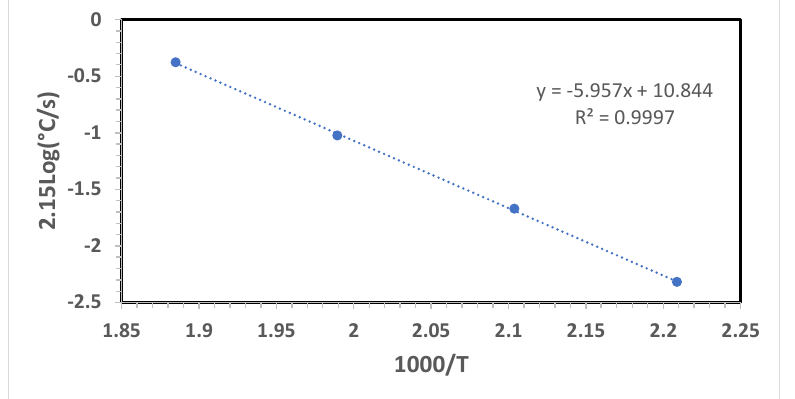
Figure 6. Determination of the activation energy for the vulcanization on compound E, Table 1 according to the Ozawa equation. The activation energy is represented by the slope which, multiplied by the gas constant R it gives an E # = 49.5 kJ/mol. The Kissinger method gives a comparable activation energy of E # = 49.0 kJ/mol.